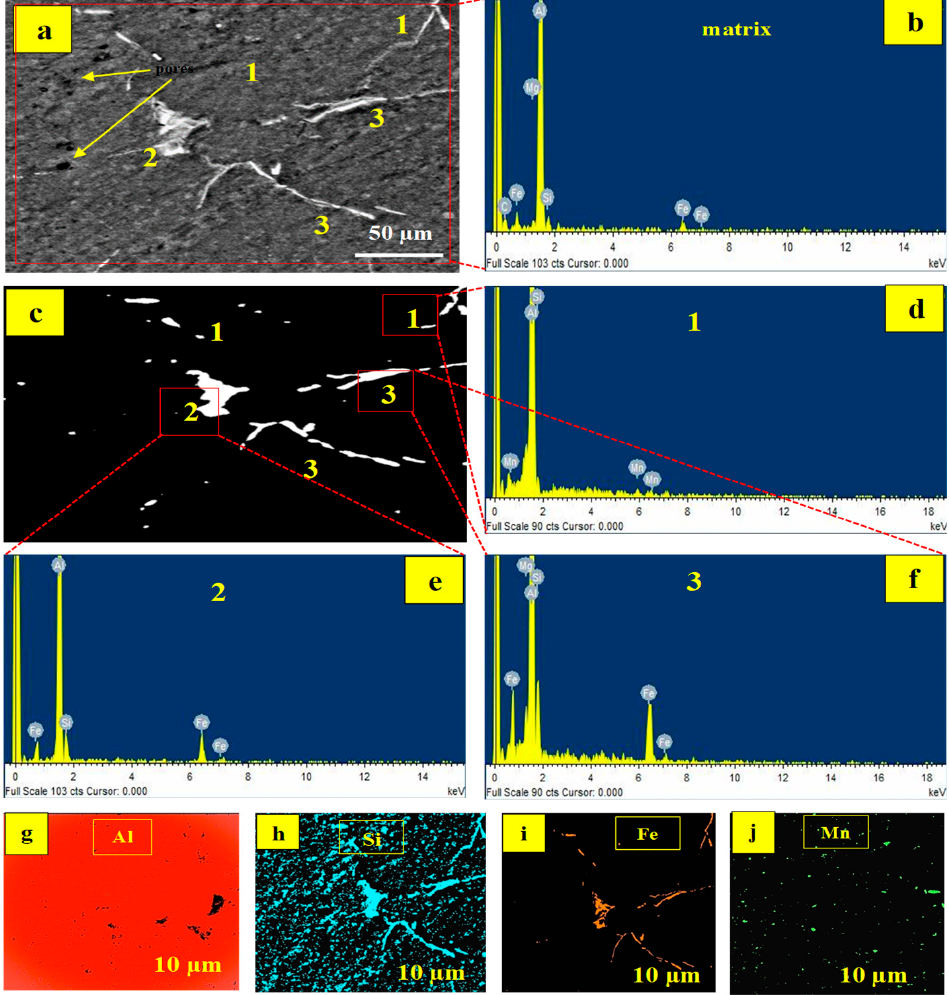
Figure 6. Morphology of specimen cast at 900 °C with a formulation of 6% PKA/4% RHA expressed in ( a ) SEM image ( b ) EDS result for the matrix ( c ) fluorescence morphology and EDS results on ( d ) spot 1 ( e ) spot 2 ( f ) spot 3 ( g – j ) elemental maps. Figure 6d–f highlight the EDS-determined composition of the spots. The elements discovered in spot 1 are Mg and Si, as in specimen 6% PKA and 4% RHA; spot 2 is Al, Fe,